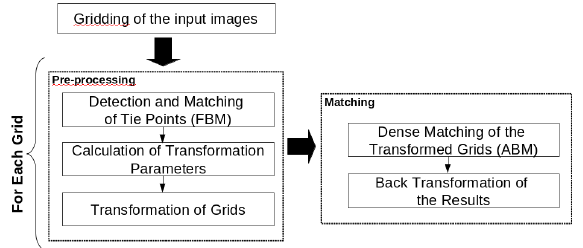
Figure 2: Dense matching flowchart